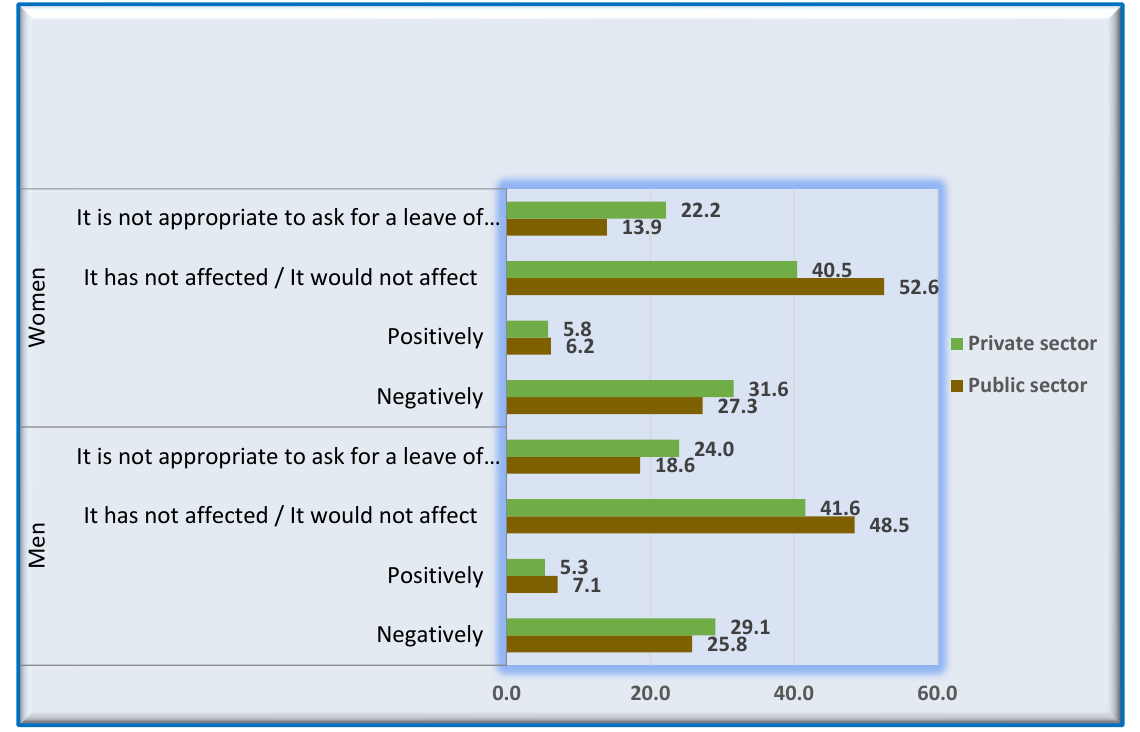
Figure 11. how would it affect requesting a level of absence for family reasons according to sex and activity sector (percentage distribution of responses). Source: Authors with data from the 2010 Quality of Life at Work Survey ( Encuesta de calidad de vida en el trabajo ).